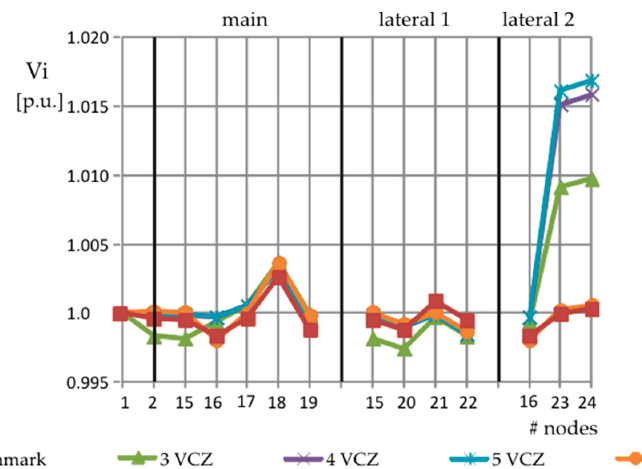
Figure 18. Voltage profiles for Case X —DG and BESSs: P algorithm—feeder 2. Figure 18 : Voltage profiles for Case X — DG and BESSs: P algorithm—feeder 2. Figure 18 : Voltage profiles for Case X — DG and BESSs: P algorithm—feeder 2.